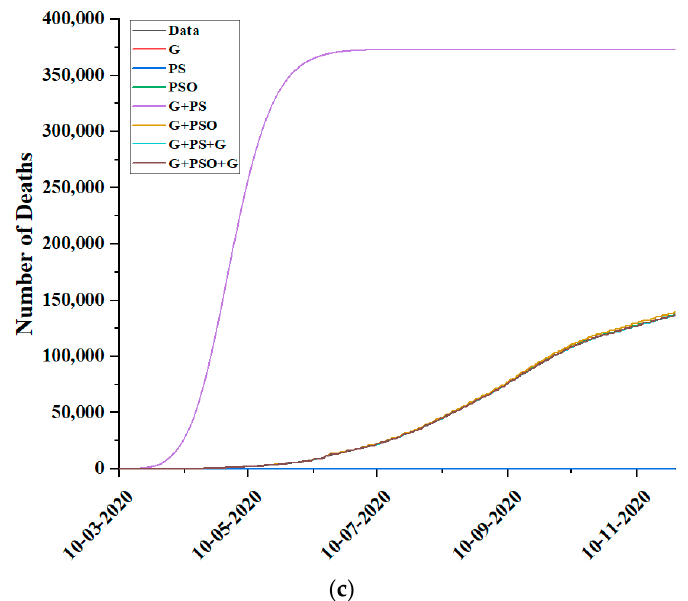
Figure 5. Comparative analysis of real time Indian epidemiologic data and fitted model by SIRD using various optimization techniques and their hybrid ( a ) Infected ( b ) Recovered ( c ) Deaths.